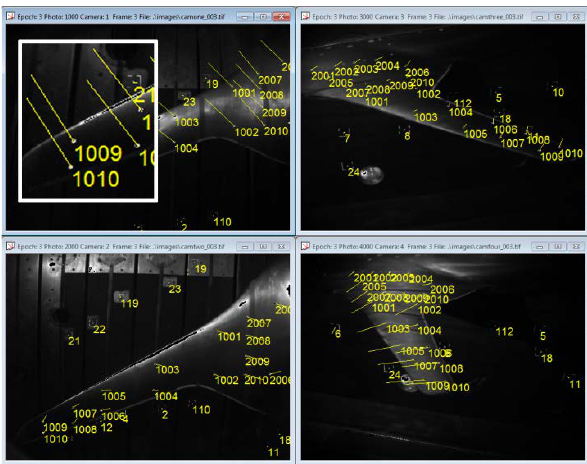
Figure 5. Camera views of a semi-span model and intersection errors for a polar sweep validation in NTF (detail view